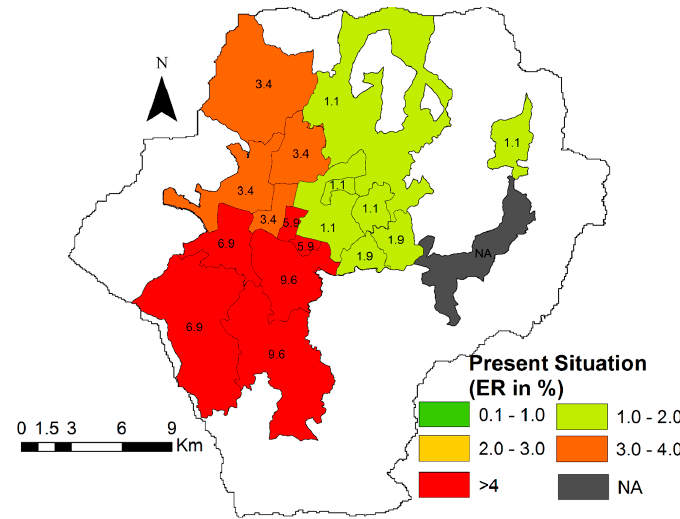
Figure 3. Current ER in various service areas of Kathmandu.